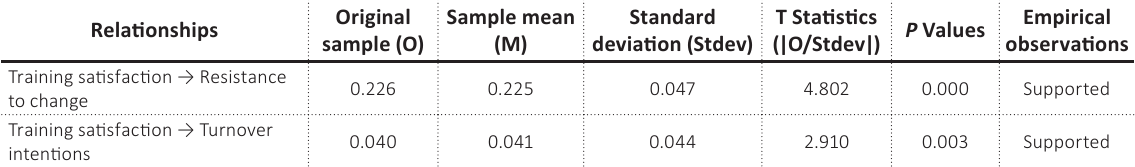
Table 6 (cont.). Hypothetical path